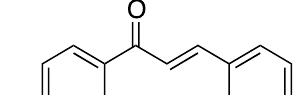
cell lines; and normal green monkey fibroblast line COS7. Table 1. Inhibitory effect of compound 1 against the human Molt 4/C8; CEM T-lymphocytes; murine P388; L1210; human cervix carcinoma HeLa; murine mammary carcinoma FM3A; estrogen-receptor-